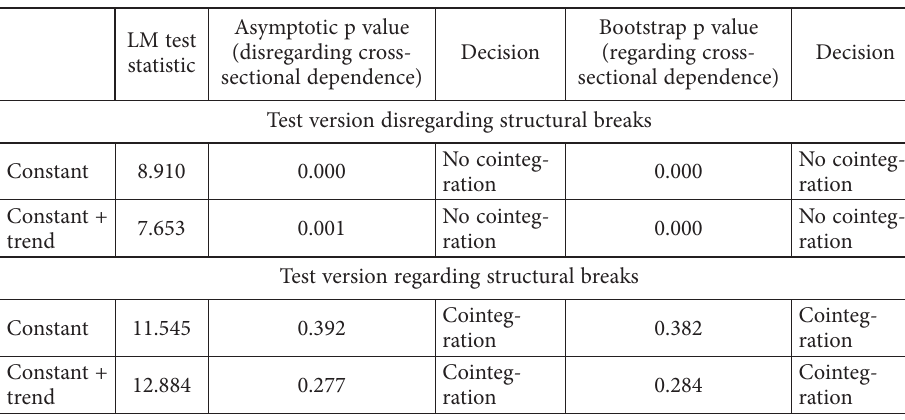
Table 6. Panel cointegration test with cross-sectional dependence and multiple structural breaks (source: own processing)